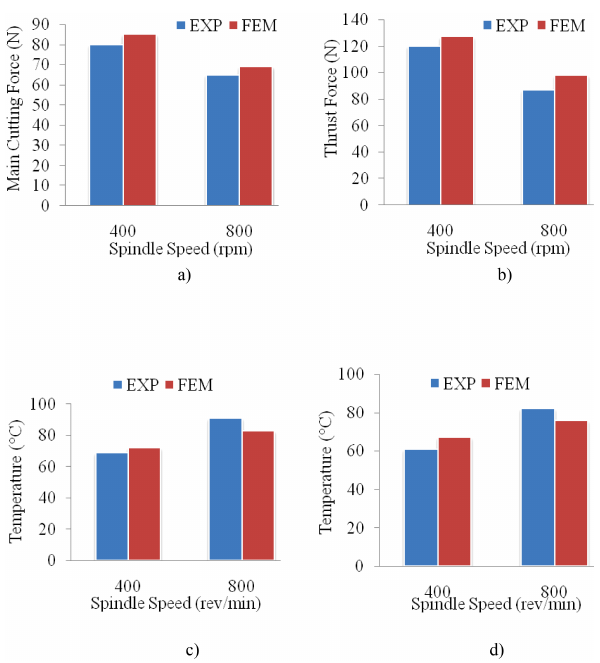
Figure 9. Experimental and FEA results: (a) main cutting force, (b) thrust force, (c) bone model temperature, and (d) K-wire tem- perature in the bone model drilling process.